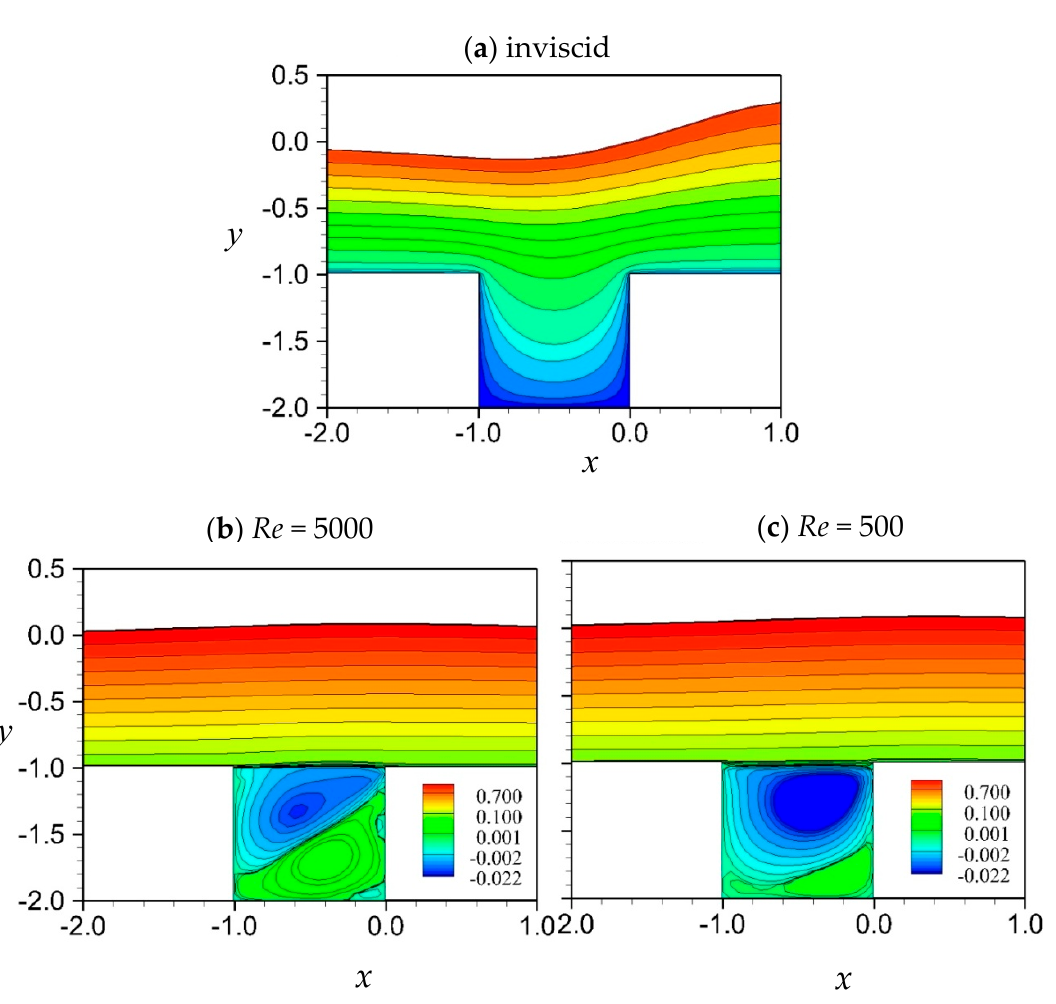
Figure 11. Streamlines for Fr = 1.0 at t = 12: ( a ) inviscid flow, ( b ) Re = 5000, and ( c ) Re = 500.